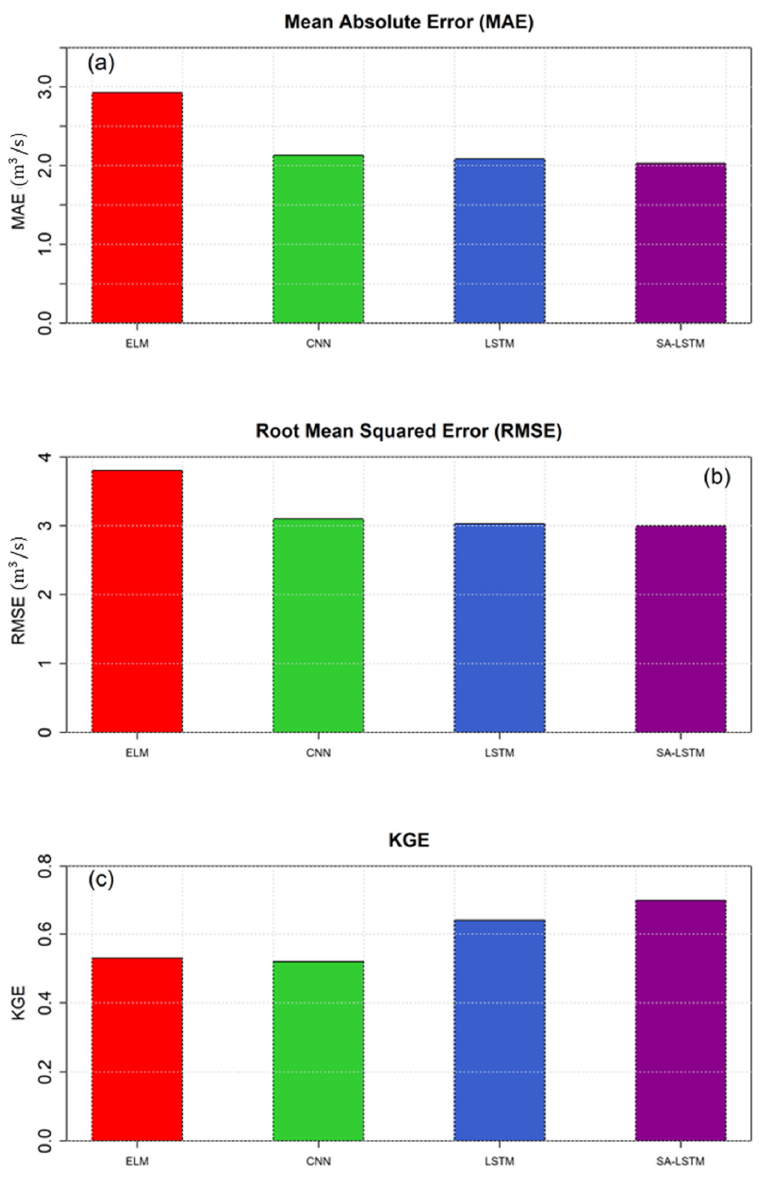
Figure 7. Evaluation of the predictive performance of the models with respect to capturing the extreme high flows during the testing period. Considering the MAE and RMSE metrics (Figure 7a,b), it is clear that the deep learn- per second) than the baseline ELM model. Thus, the deep learning models were identified